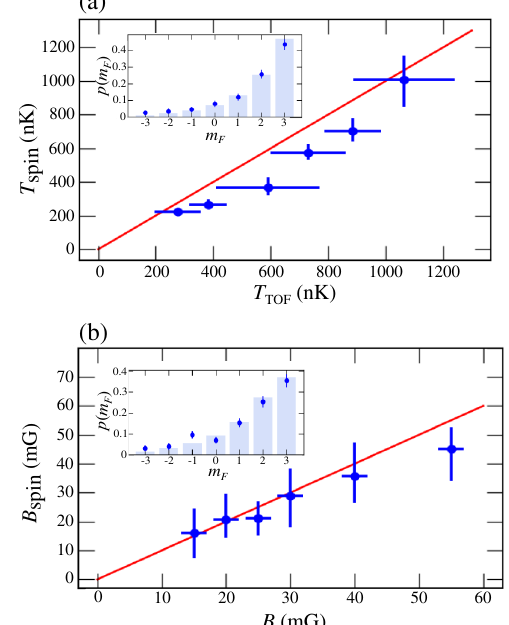
FIG. 4. Nonequilibrium quantum probing. (a) Comparison of the temperatures extracted from the spin population of Cs atoms T after 350-ms interaction time to time-of-flight temperatures of the Rb cloud T for a fixed magnetic field B ¼ 10 mG. The error TOF originate from the statistical errors on the χ 2 analysis, bars of T spin and the error bars of T reflect the shot-to-shot fluctuations in the TOF experiment (around 10% – 15%). The red line serves as a guide to ¼ T the eye T . Inset: Example of spin population. The dots spin TOF represent the data and the histogram the theory with the best-fitting ¼ 1008 þ 140 temperature, here T − 160 nK. (b) Same as (a) but with spin the magnetic field B for a fixed temperature T ¼ 1 μ K. Inset: Spin ¼ 20 . 7 8 . 9 population with B − 6 . 2 mG. 0 spin